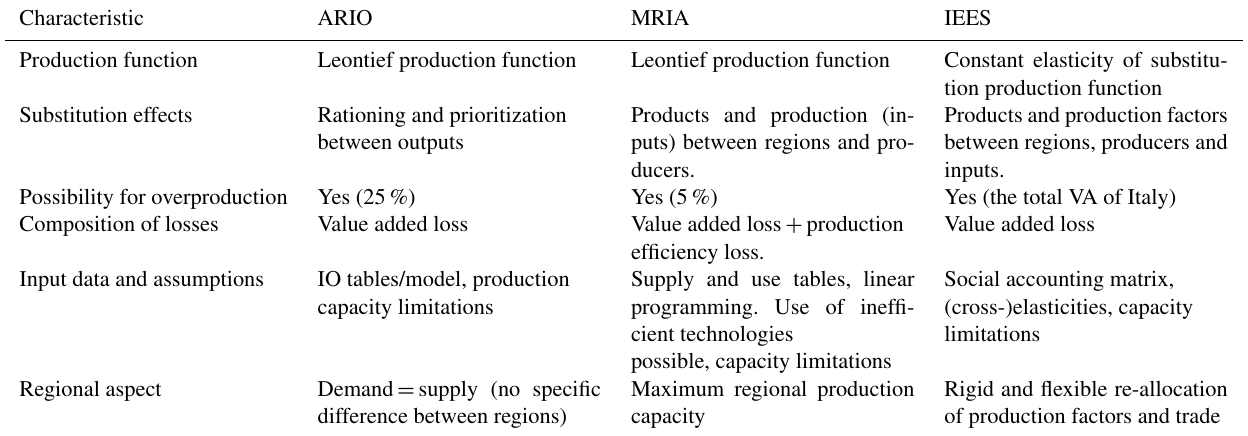
Table 2. Key characteristics of the used models. Characteristic